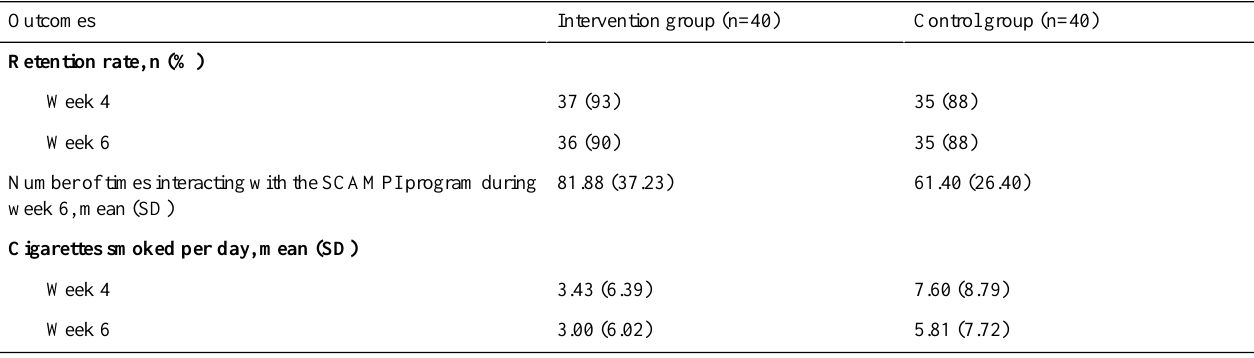
Table 2. Summary of participation and smoking data.